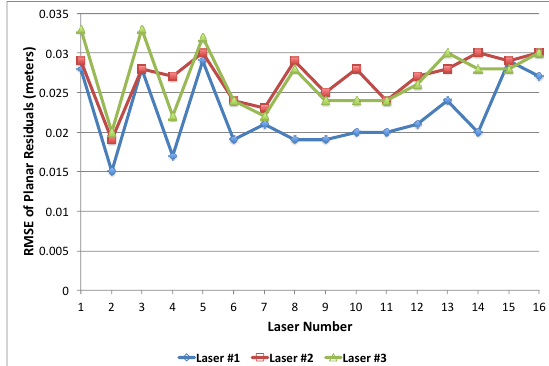
Figure 4: VLP-16 Planar Residuals by Laser # for the three VLP-16 Units Evaluated after geometric calibration